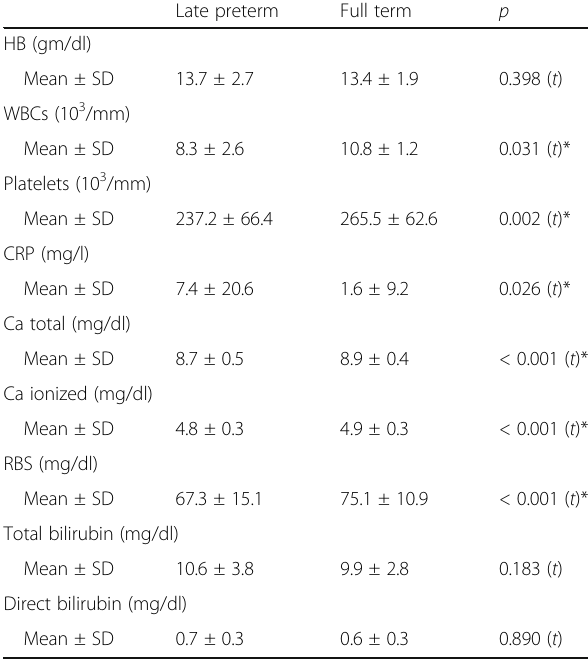
Table 4 Laboratory investigations done to studied